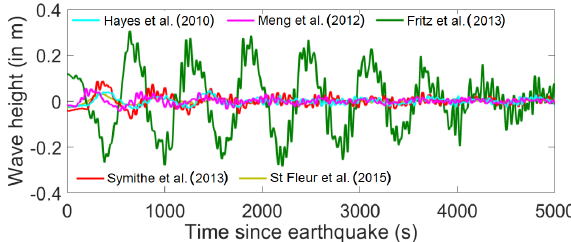
Figure 4. Water height comparison at a synthetic gauge located in the center of the Bay of Jacmel at 30m water depth. Calculation on a bathymetric grid uses a 30s